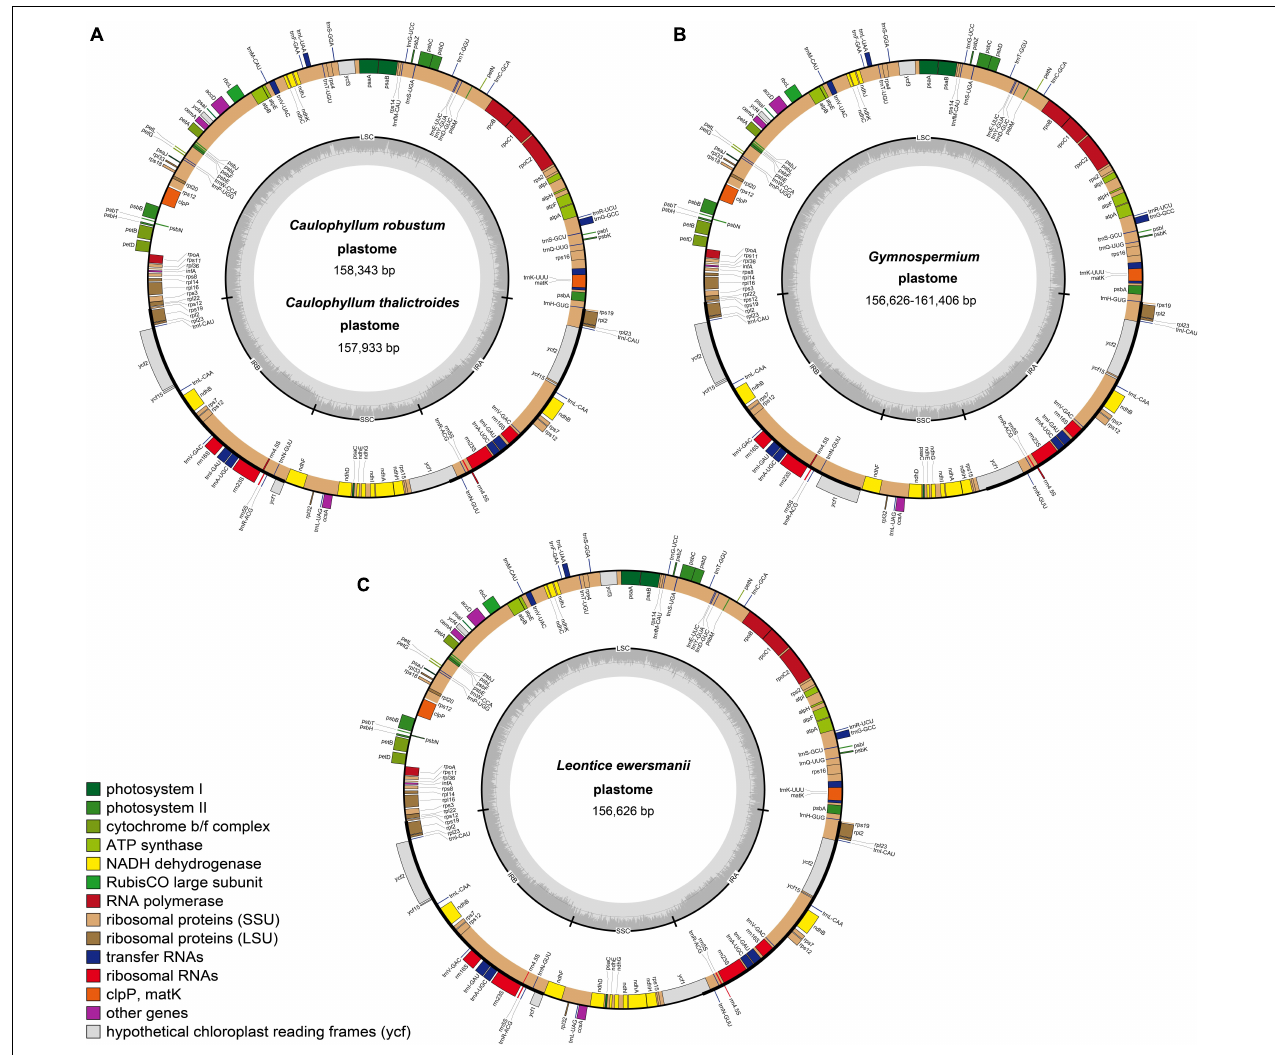
FIGURE 2 | Representative plastome maps of the newly sequenced plastomes of Nandinoideae (20 in total): (A) Caulophyllum robustum and C. thalictroides , (B) Gymnospermium , (C) Leontice ewersmannii .